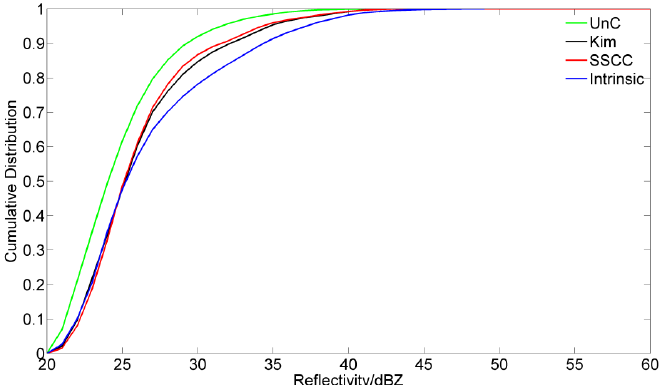
Figure 18. Cumulative distribution of reflectivity for the stratiform rain.